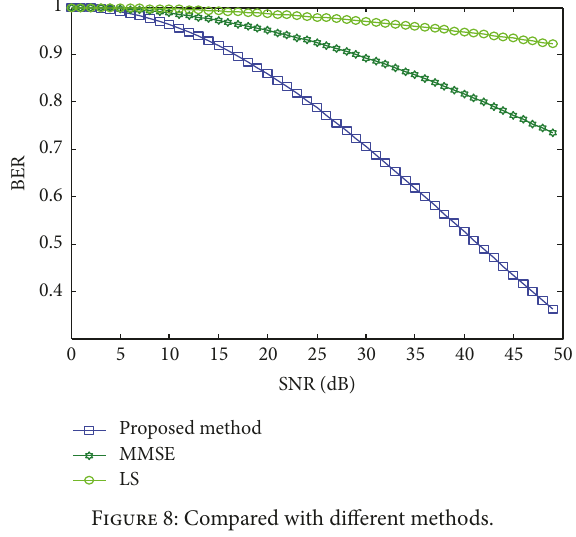
Figure 8: Compared with different